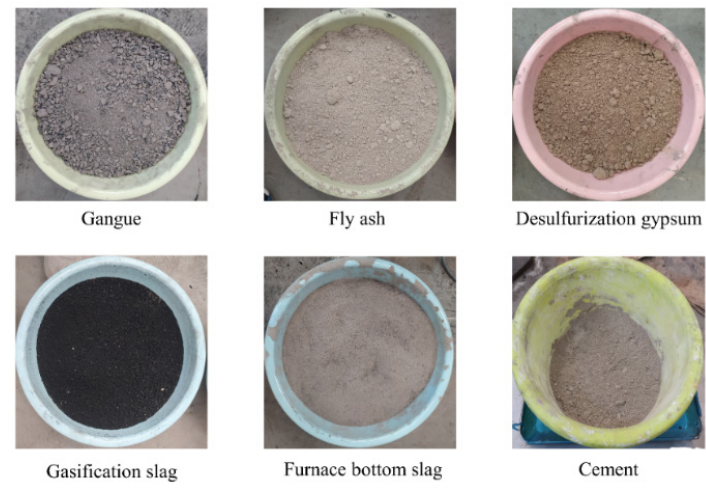
Figure 1. Experimental materials.